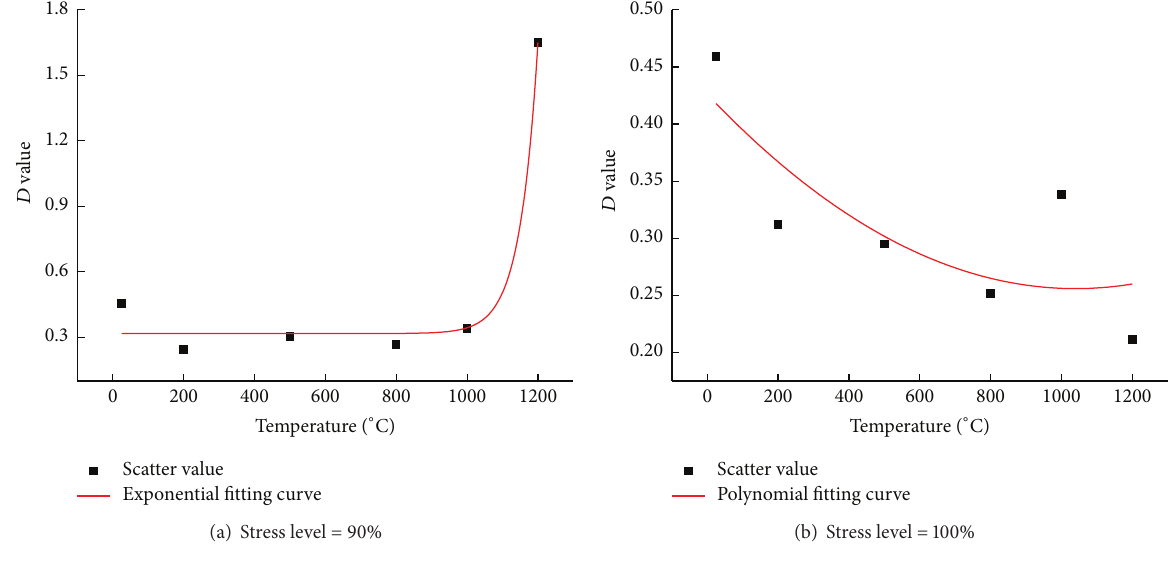
Figure 13: The effect of heat temperature on the 𝐷 value at stress levels 90% and